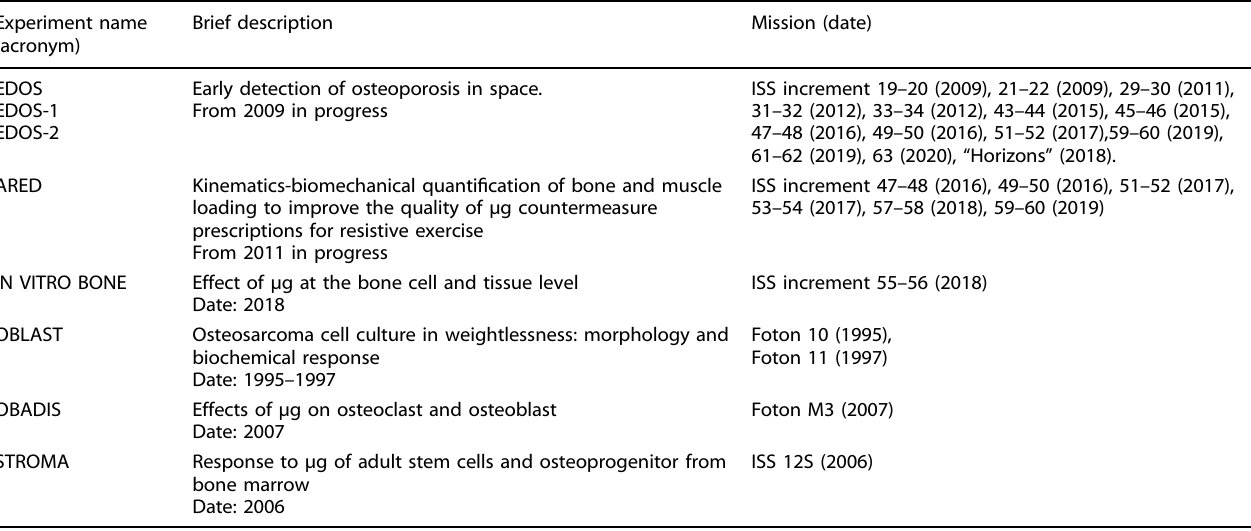
Table 4. Experiments performed in space related to osteopenia space fl